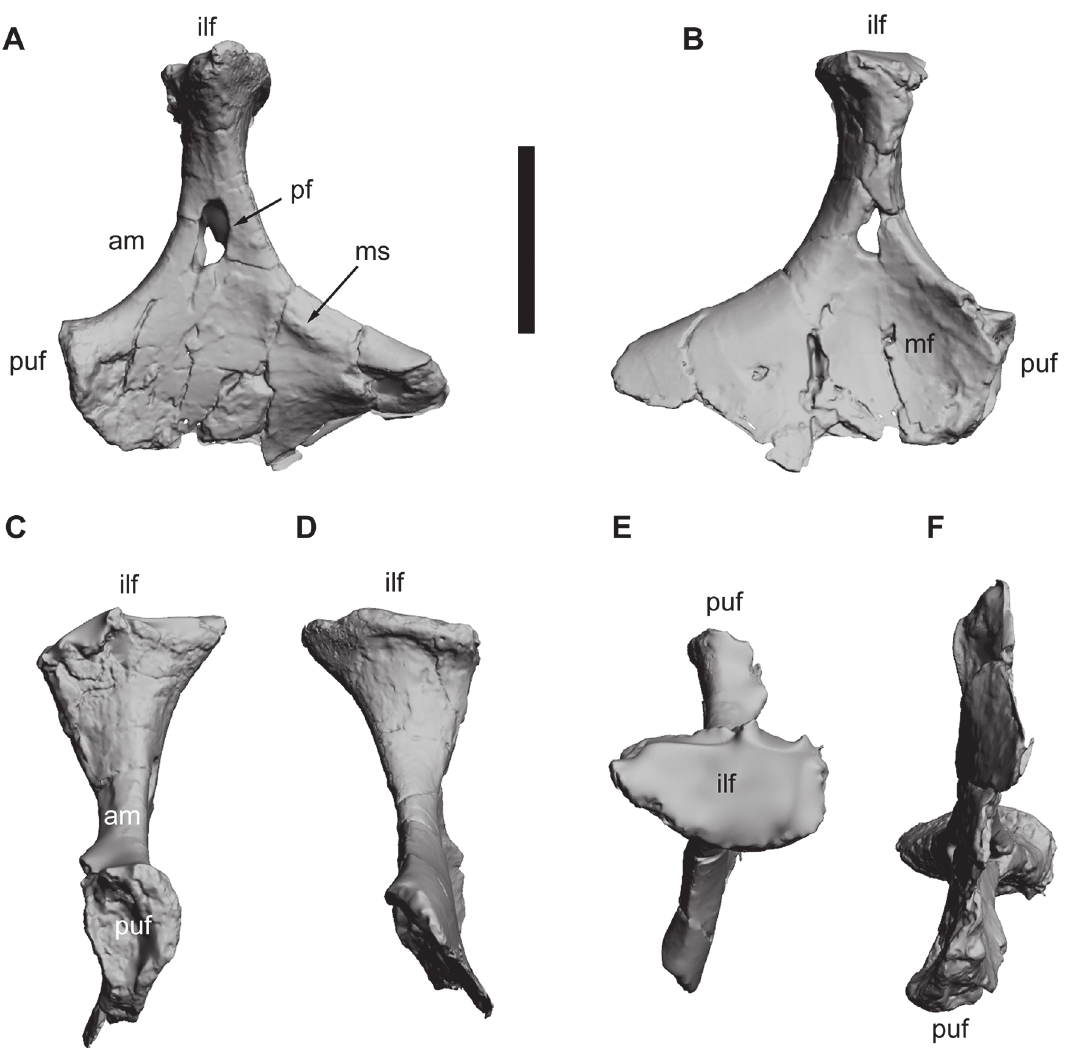
Fig 20. Left ischium of Tataouinea hannibalis . Ischium in lateral (A), medial (B), cranial (C), caudal (D), proximal/dorsal (E), distal/ventral (F) views. Scale bar: 10 cm. Abbreviations: am, acetabular margin; ilf, iliac facet; mf, medial fossa; ms, muscle scar; pf, pneumatic foramen; puf, pubic